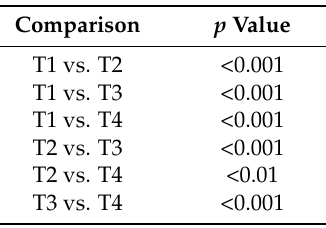
Table 6. CD20 Dunn’s multiple comparison between groups.